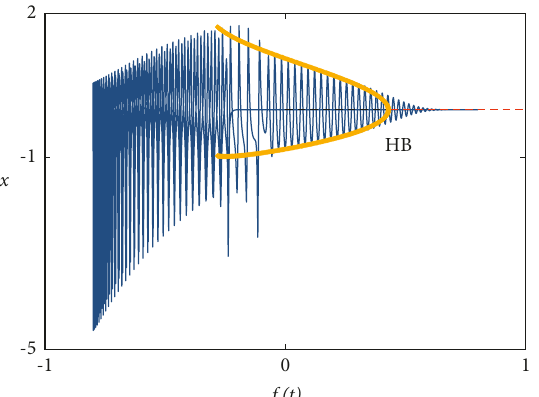
Figure 7: Transformed phase portrait on the plane of black line corresponds to stable trivial steady state and the green line represents the amplitude of the limit cycle oscillation. Other parameter values are fixed same as in Figure